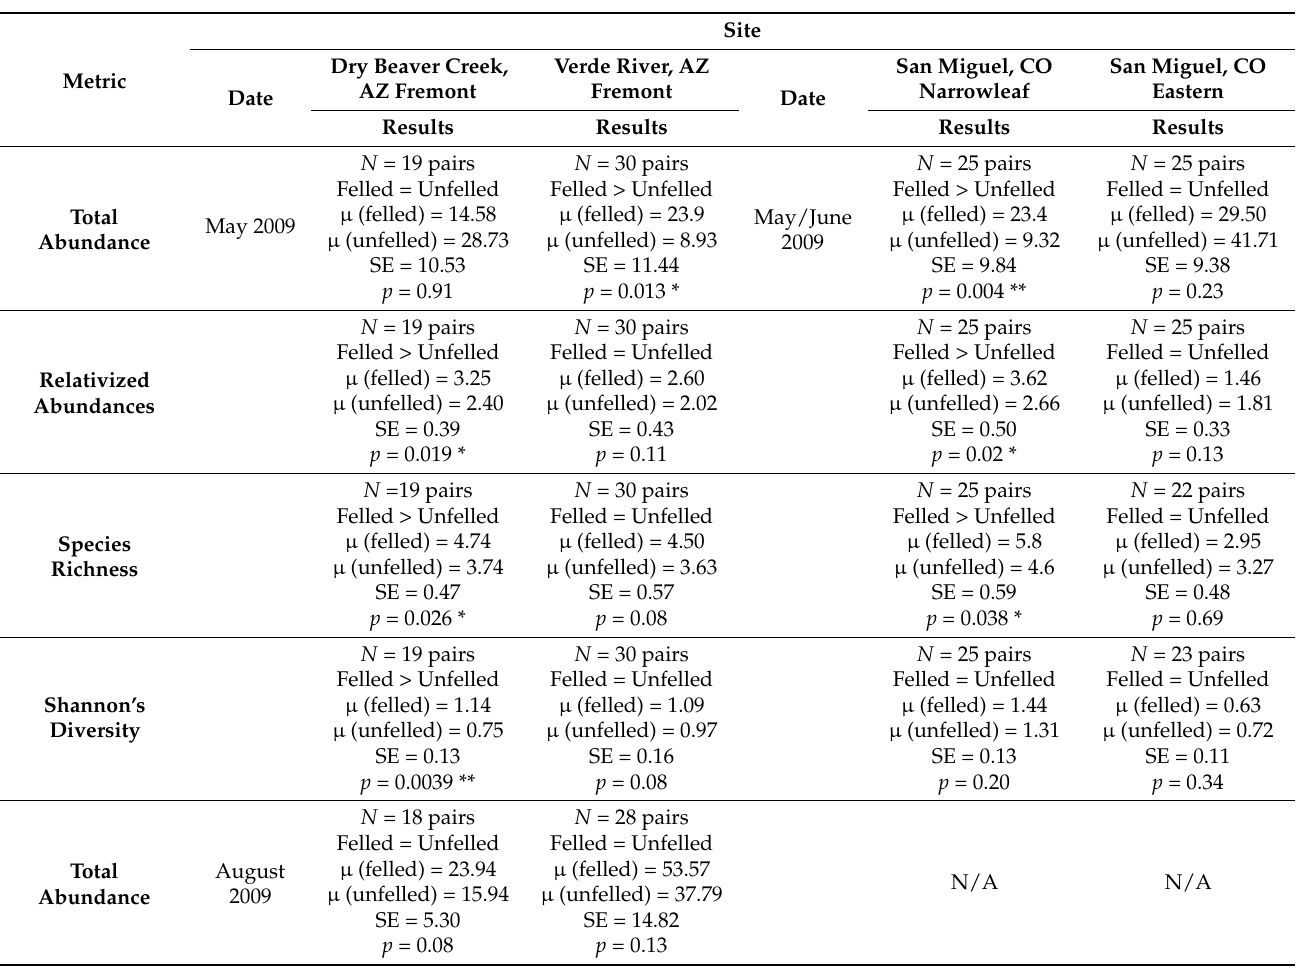
Table 2. Arthropod surveys on juvenile growth of Fremont cottonwood at both Arizona sites and on narrowleaf cottonwood on the San Miguel River generally showed greater relativized abundance, species richness and diversity in resprout growth of felled trees than in unfelled control trees. Eastern cottonwood on the San Miguel River showed no responses. Directionality of each difference, if any, along with the corresponding p -value is reported. All analyses were conducted using a non- parametric Wilcoxon-Signed Rank Test, and Bonferroni adjusted for an α of 0.008 for all sites. p -values with an asterisk * are significant prior to Bonferroni-adjustments; p -values with two asterisks ** are significant with Bonferroni-adjusted α . With Fremont cottonwood, we found significant differences in 10 out of 16 analyses without Bonferroni adjustments and 7 out of 16 analyses when using Bonferroni adjustments. In narrowleaf cottonwood, we found significant differences in 3 out of 4 analyses without Bonferroni adjustments and 1 out of 4 analyses with Bonferroni adjustments. No significant differences were found in 4 analyses with Eastern cottonwood.